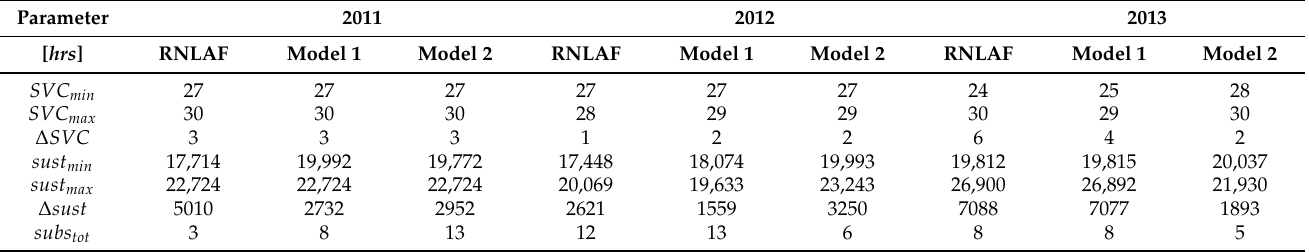
Table 4. Numerical results of the CMP optimization model with respect to serviceability, sustainability and number of substitutions for the years 2011–2013. Actual RNLAF results (left) are presented alongside the results of two optimization model runs for the same years (middle and